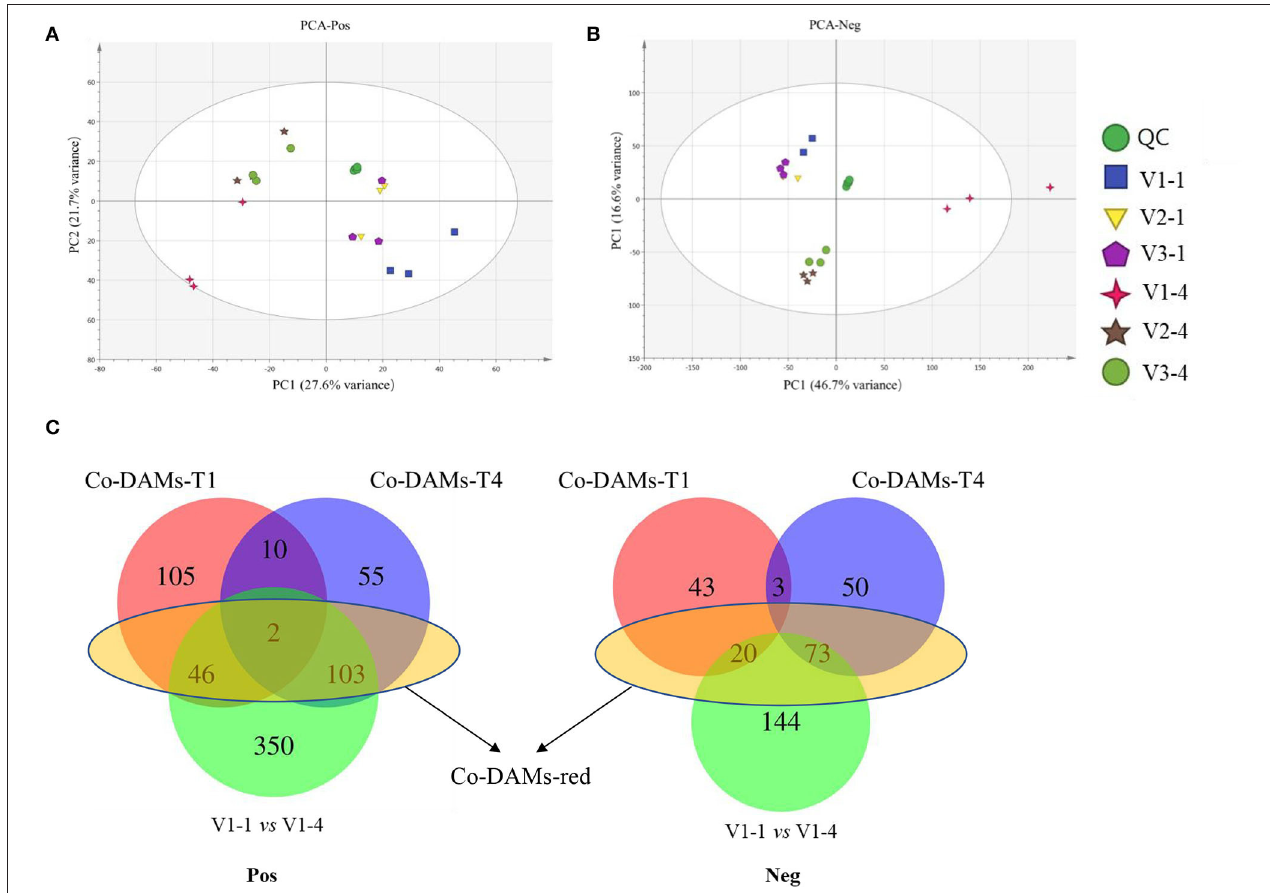
FIGURE 2 | PCA analysis and Venn diagrams of metabolomic data. (A) PCA analysis of metabolomic data under positive mode. (B) PCA analysis of metabolomic data under negative mode. (C) Venn diagram analysis of differentially accumulated metabolites. V1-1, V2-1, and V3-4 represent the unopened petals of V1, V2, and V3 at stage 1. V1-4, V2-4, and V3-4 represent the unopened petals at stage 4. Co-DAMs-T1 represents the common differentially accumulated metabolites between V1 vs. V2 and V1 vs. V3 at stage 1. Co-DAMs-T4 represents the common differentially accumulated metabolites between V1 vs. V2 and V1 vs. V3 at stage 4. Co-DAMs-red represents the metabolites that were considered key metabolites functioning in red color. Pos represents the positive mode and Neg represents the negative